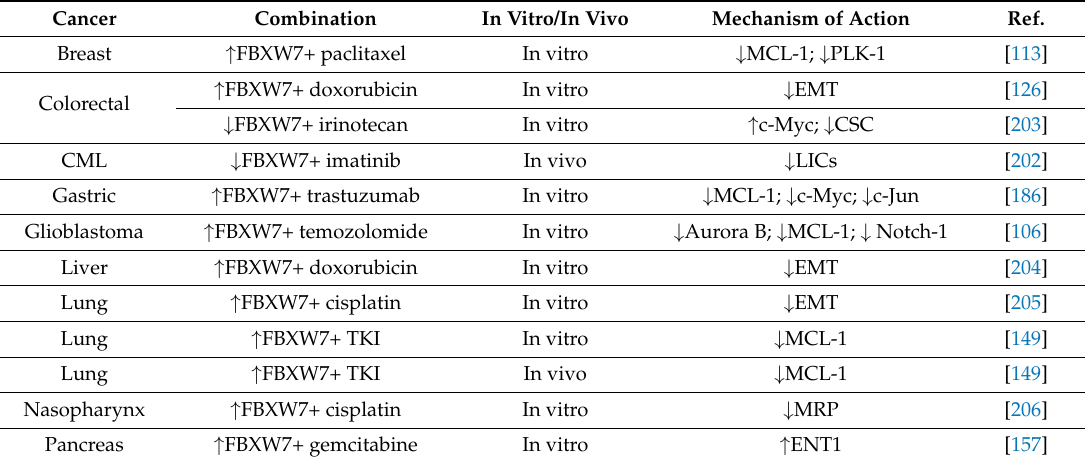
Table 2. Role of FBXW7 in cancer cell